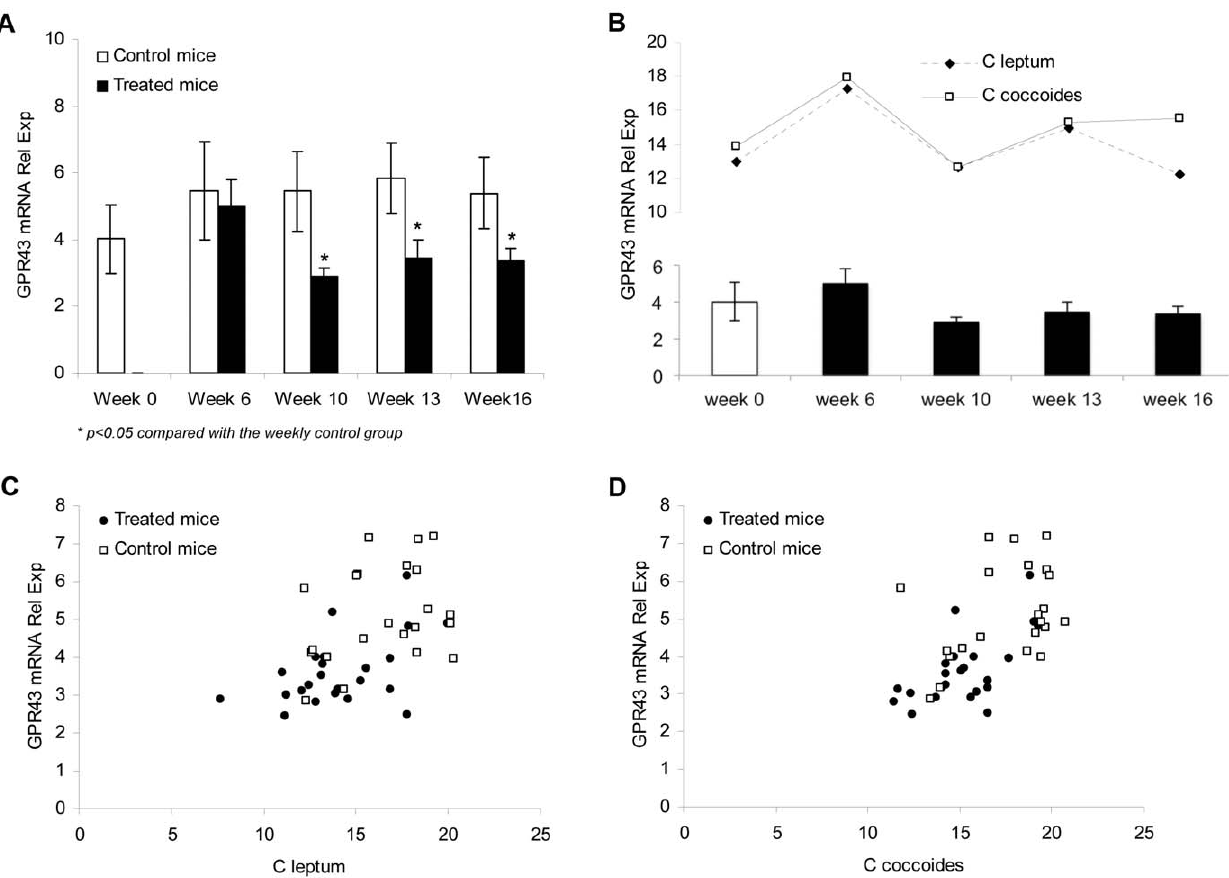
Figure 3. Specific G protein-coupled receptor (GPR)-43 gene expression along the study protocol. (A) Temporal mRNA expression of GPR-43 in PMN cells of treated and control mice. Values were measured by quantitative real-time PCR and are shown as mean 6 standard deviation for control (n=4/week) and treated mice (n=6/week) along the 16 weeks of study. (B) Relative mRNA expression of GPR-43 PMN levels, and C. leptum and C. coccoides counts from samples of intestinal cecum content in treated animals (n=6/week) are shown at different laparotomy weeks. (C, D) Correlation between GPR-43 PMN gene expression levels and C. leptum (C) or C. coccoide (D) counts in all control (n=22) and treated mice (n=24) included in the